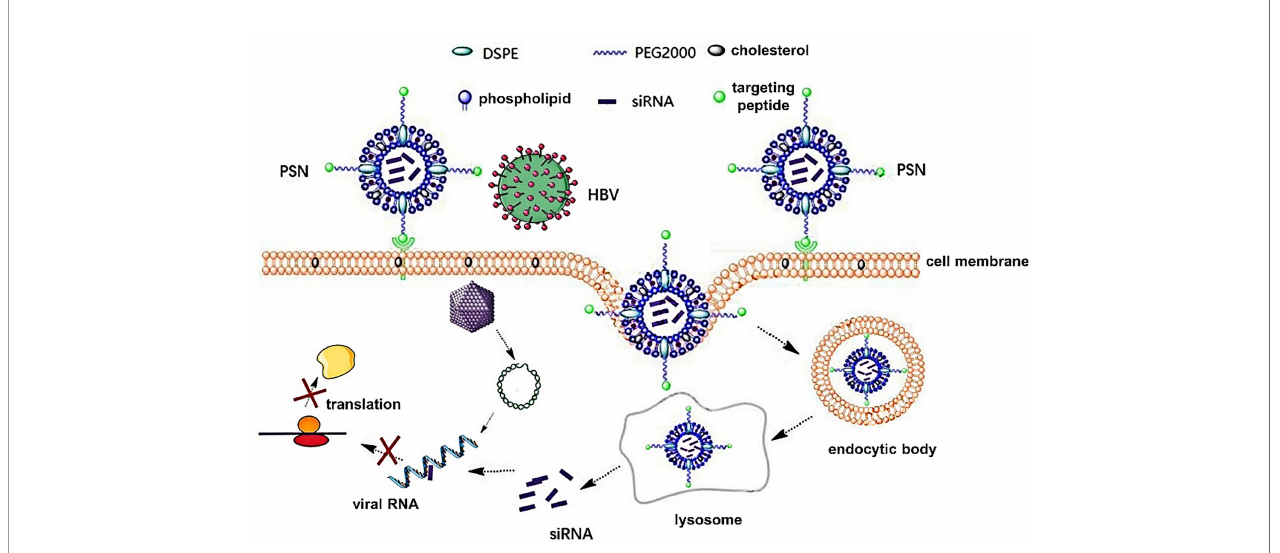
FIGURE 1 | Principles of PreS/2-21-conjugated nanoparticle with siRNA on targeted inhibition of hepatitis B